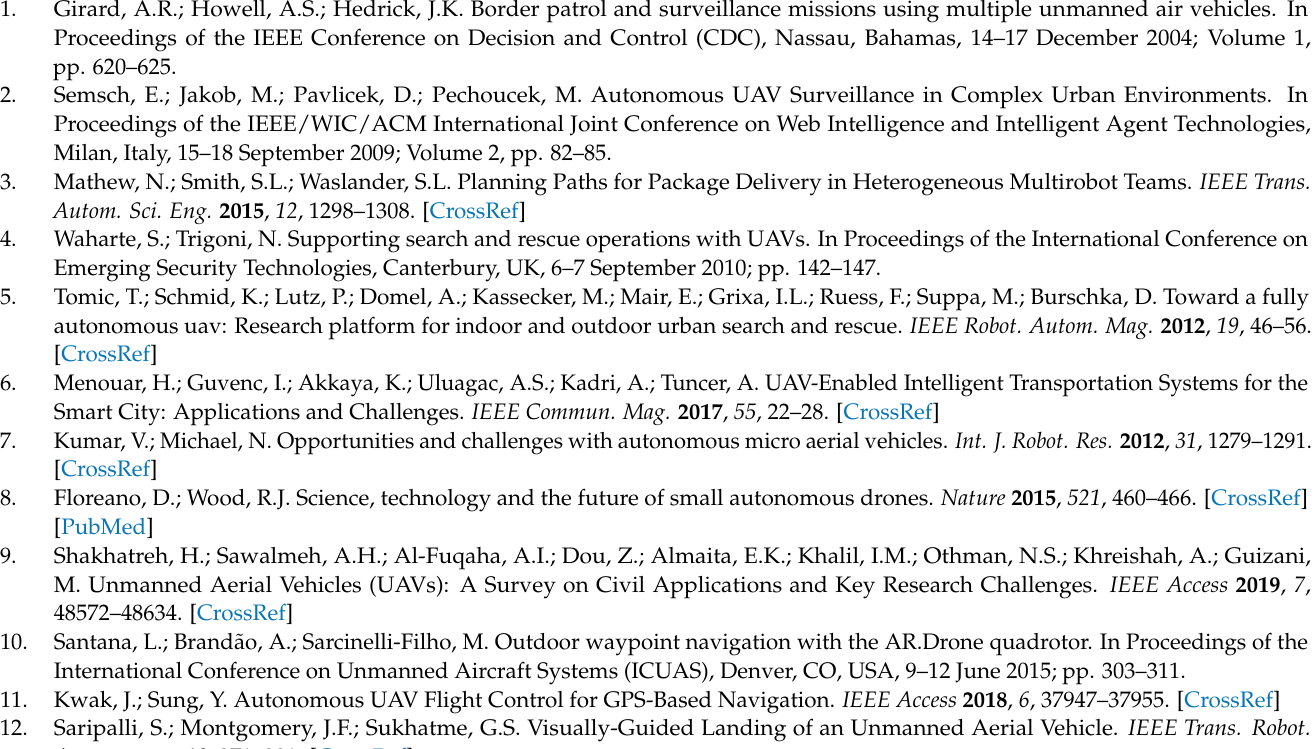
object on detection. The green circle edge represents the detection via the hybrid detection algorithm. Figure S3: Results of the additional experiment. The purple ball in the center is the target subject, and the green edge represents the detection